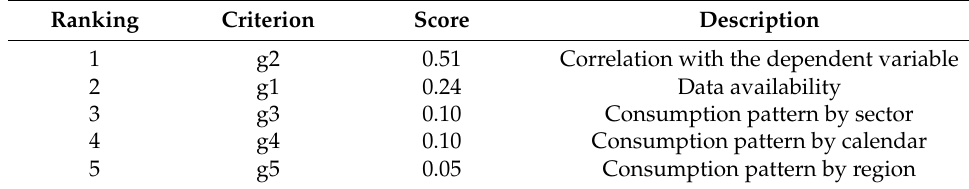
Table 11. Criteria score ranking.